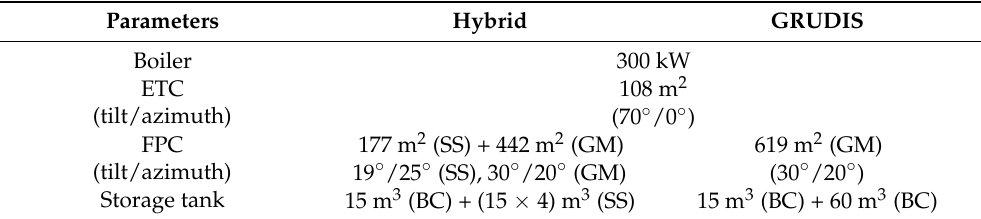
Table 1. Heat supply—Overview of the heat supply configuration for the two distribution concepts investigated in this study. BC = boiler central, SS = Substation, GM = ground-mounted.